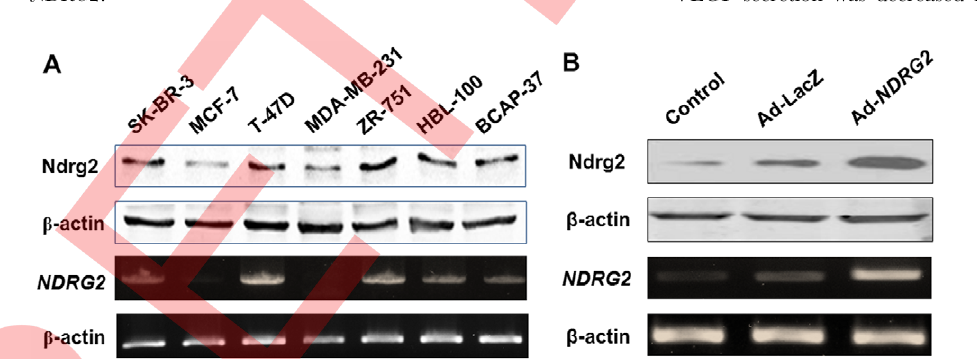
Figure 1. Expression of NDRG2 in breast cancer cell lines and the effect of Ad- NDRG2 . (A) T-47D, MCF-7, BCAP-37, HBL-100, ZR-751, SK-BR-3 and MDA-MB-231 cells were collected for extraction of protein and RNA and analyzed for NDRG2 expression using western blot and RT-PCR. (B) NDRG2 low-expression MCF-7 breast cancer cells were infected by adenovirus carrying NDRG2 (Ad- NDRG2 ) or negative control LacZ (Ad-LacZ). Thereafter, protein and RNA from these cells were extracted and subjected to western blot and RT-PCR analysis. b -actin was used as a loading control. The data are representative of three independent experiments.